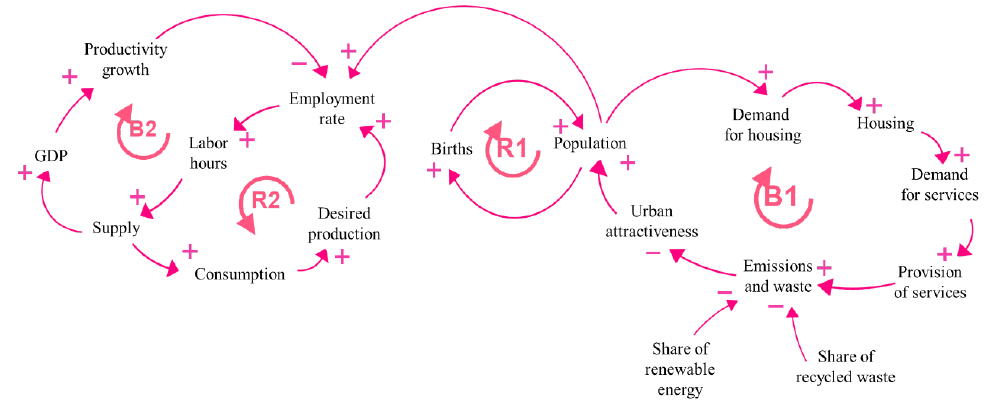
Fig. 4. Causal loop diagram for main feedbacks loops in Urban Resilience SD